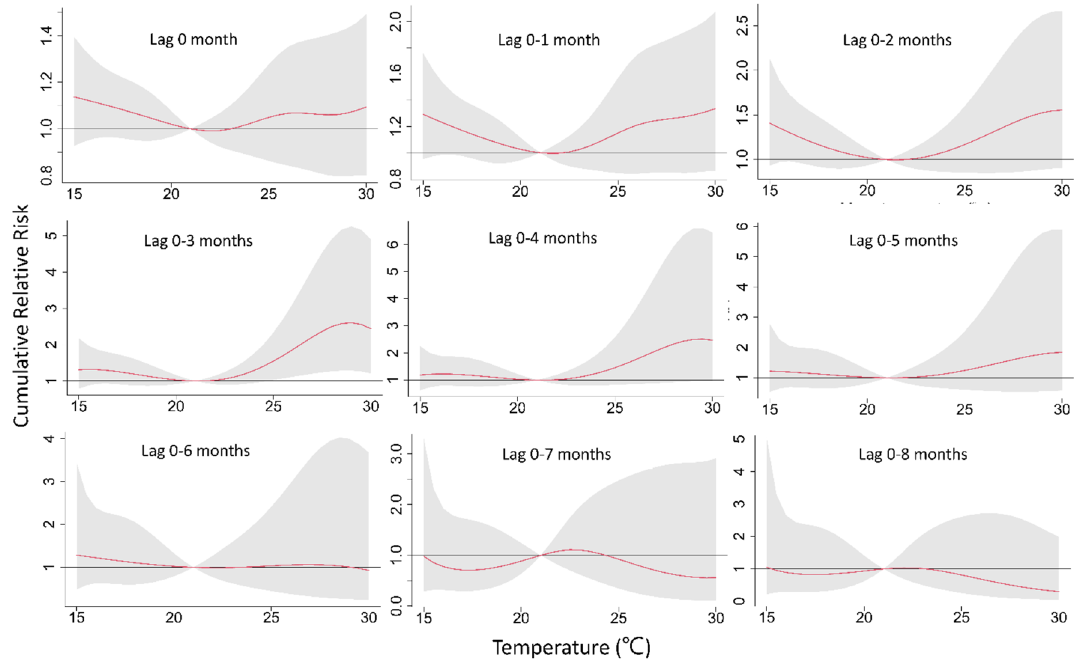
Figure 5. Exposure–response curves of monthly mean temperatures and cumulative RRs of stillbirth using quasi-Poisson regression with the DLNM and different lag periods; the reference corresponds to 21 °C. Taiwan, 2009–2018. Cumulative RRs (red line) and 95% CIs (gray zone) for stillbirths over different lag periods (0, 0–1, 0–2, 0–3, 0–4, 0–5, 0–6, 0–7, 0–8, and 0–9 months). Estimates are relative to the optimal temperature (21 °C) for the study area as a reference. We observed a U-shaped association between stillbirth risk and temperature during lag 0–1, 0–2, and 0–3 months. Heat stress has the highest cumulative RR during the third trimester (lag 0–3 months). The overall cumulative effect of hot temperatures was larger than that of cold temperatures.